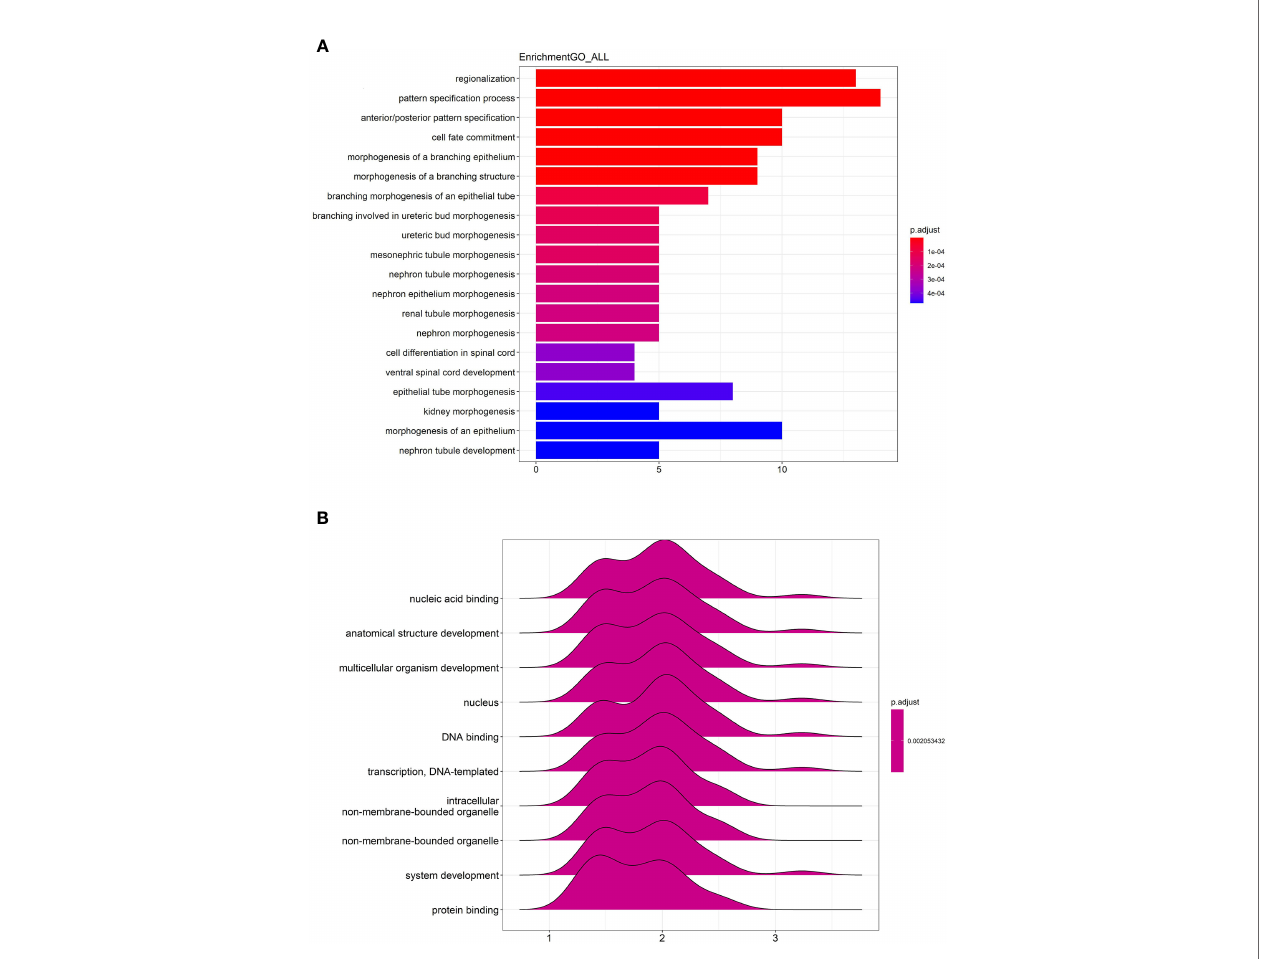
FIGURE 6 | GO enrichment and GSEA analysis of all differentially expressed genes. (A) The top 20 most signi fi cant changes in the GO enrichment analysis. (B) The top 10 most signi fi cant changes in the GSEA enrichment